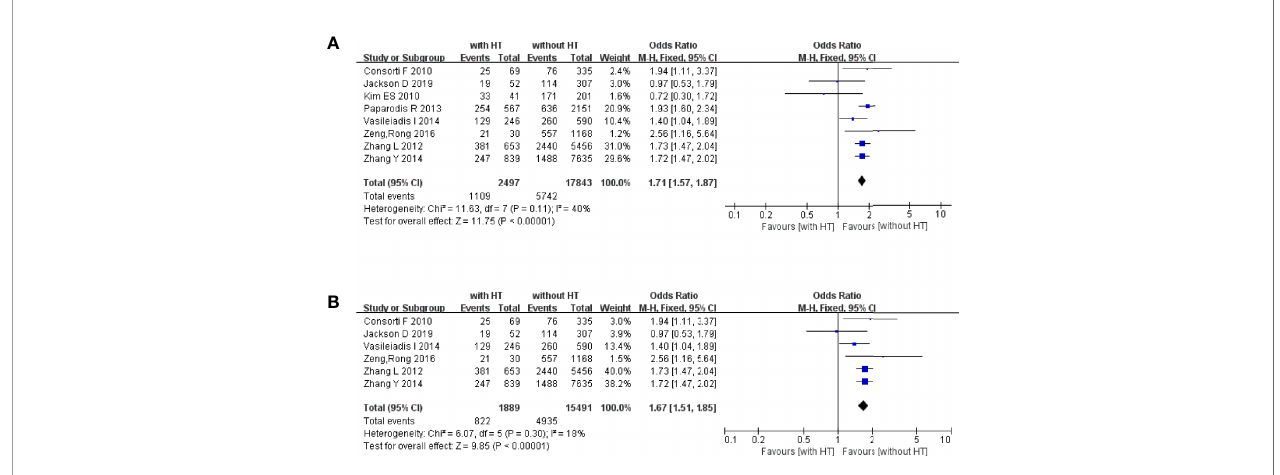
FIGURE 2 | HT as a risk factor of TC and PTC: (A) forest plot of HT and TC and (B) forest plot of HT